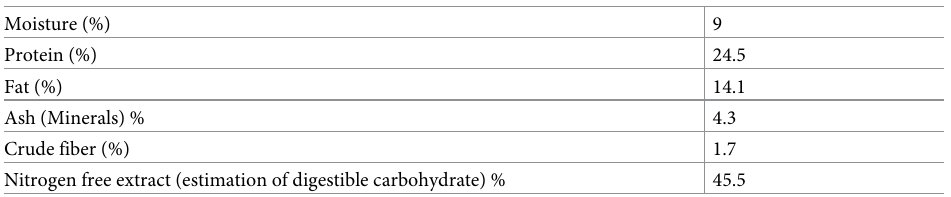
Table 2. Guaranteed analysis of the test and control diets.